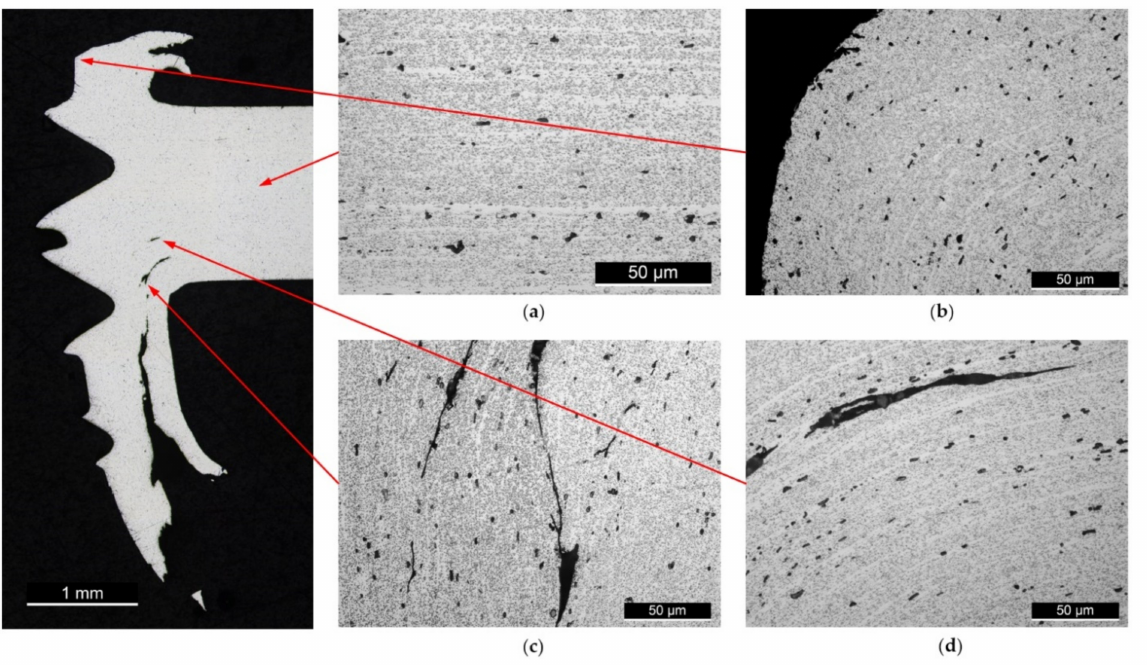
Figure 9. Representative optical microscopy images of the etched cross-section of the ( a ) parent material, and ( b – d ) deformed regions close to the thread surface for S3 (rotation speed of 3000 rpm). The corresponding locations of the micrographs are marked by the red arrows in the left macrograph. Note the interlamellar tear along the flow line direction observed in ( c , d